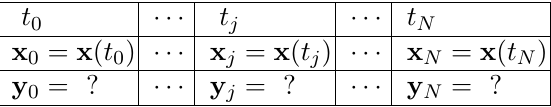
Table 1 : Experimental